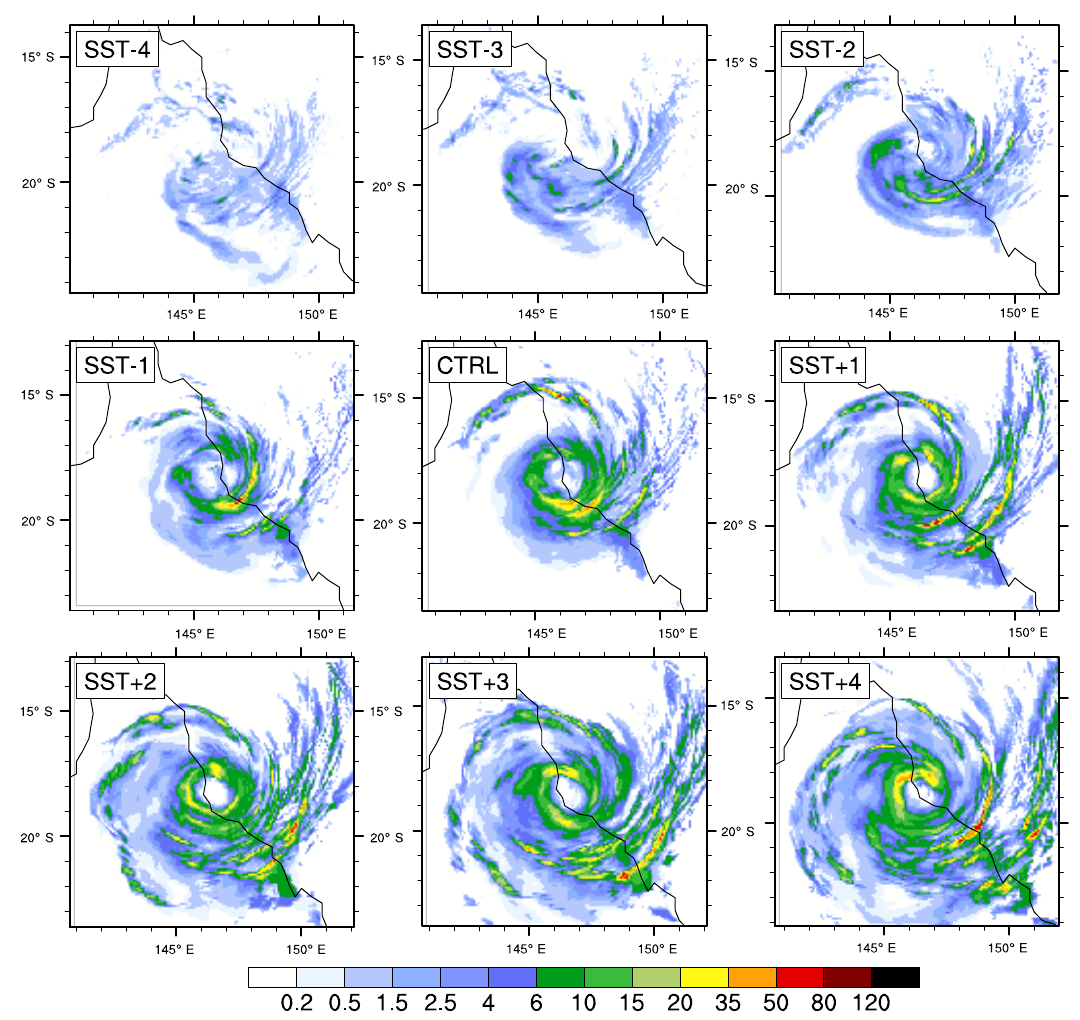
Figure 8. 30min precipitation rate (mmh − 1 ) as the storm makes landfall for each of the nine simulations.